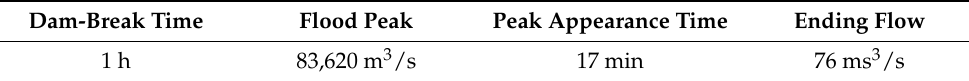
Table 3. Dam-break flow calculation result ( H = 700 m).